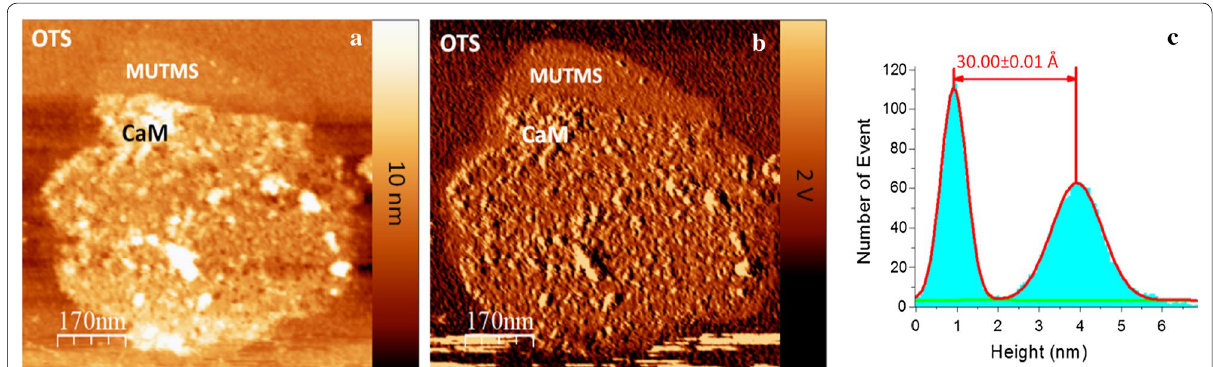
Fig. 4 A partially covered CaM layer on the MUTMS pattern. a Ac mode topography image. b Corresponding phase image. c Histogram corre- sponding to protein fully covered area in ( a ). The distance between the two peaks in the histogram specifies the height of the CaM pattern over